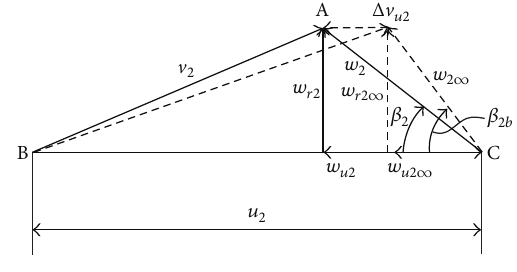
Figure 2: Velocity triangle at impeller exit.